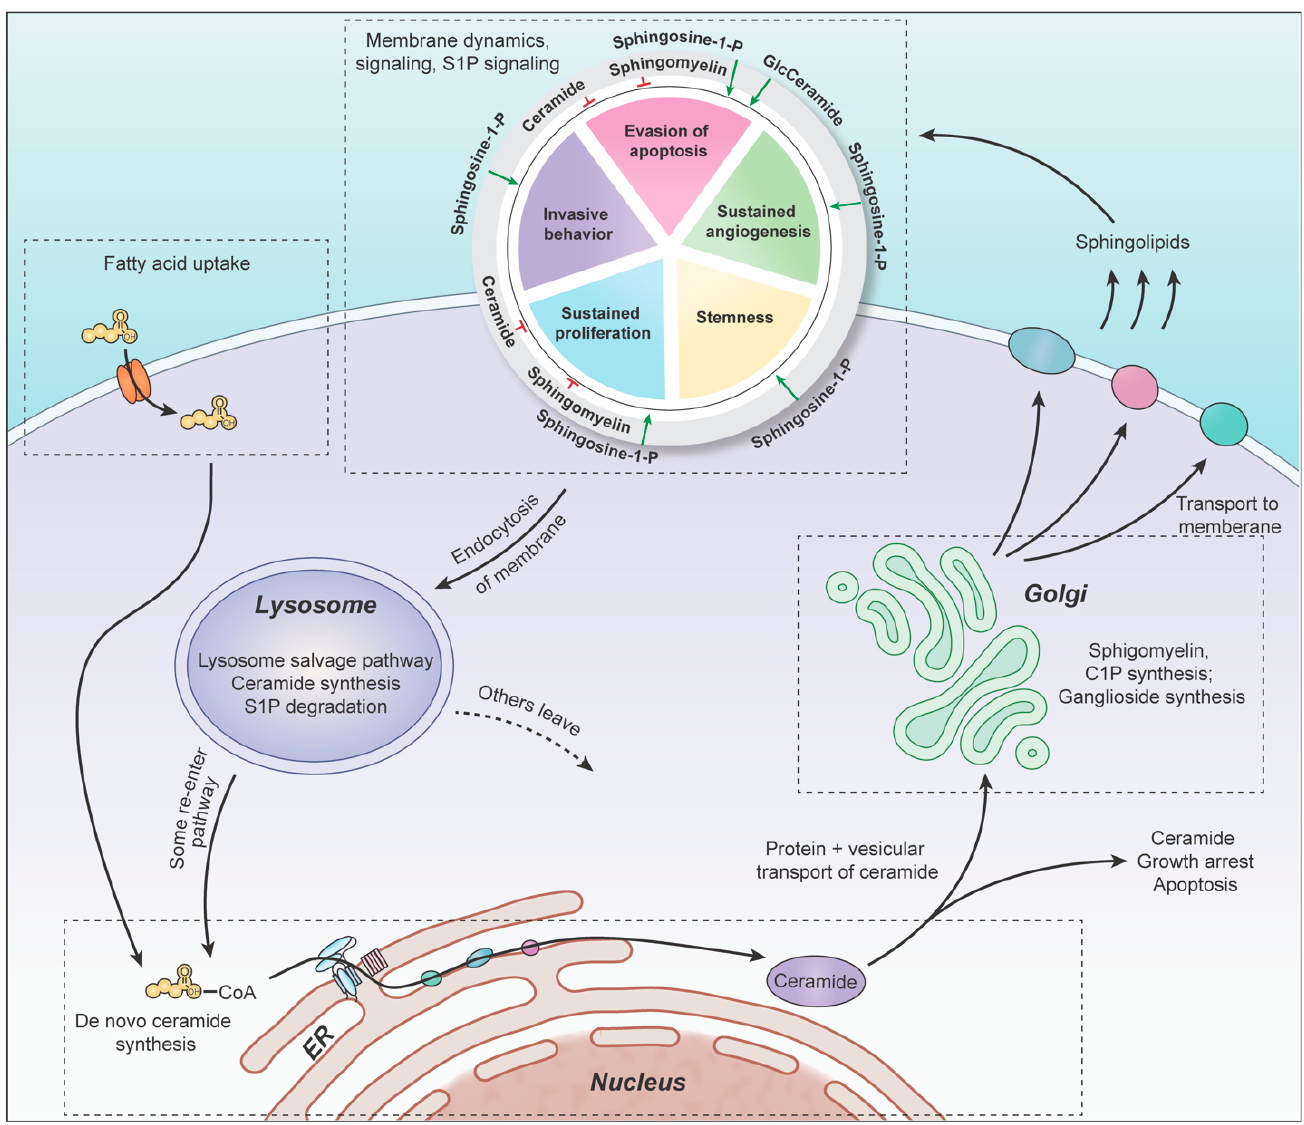
Figure 4. Compartmentalization of the various parts of sphingolipid metabolism. Each compartment is marked by a dashed rectangle. Fatty acids such as PA are taken up by the cell and transported to the ER, where they are incorporated into de novo ceramide synthesis. The ceramide is then transported to the Golgi for the synthesis of complex ceramides, such as sphingomyelin or gangliosides, which are sent to the plasma membrane to carry out their signaling functions, impacting the hallmarks of cancer. As parts of the membrane are endocytosed, sphingolipid metabolites are degraded by the lysosomal enzymes and recycled. The levels of these metabolites affect different hallmarks of gliomas.